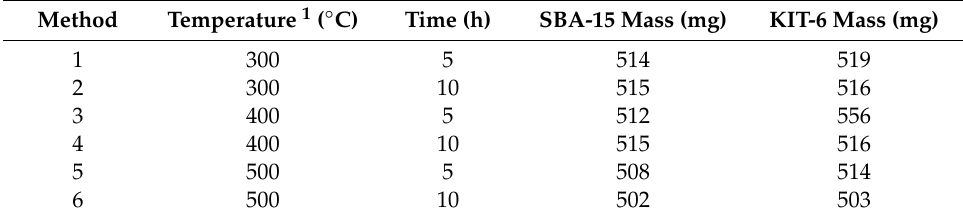
Table 1. Methodologies used for the calcination of SBA-15 and KIT-6 samples.